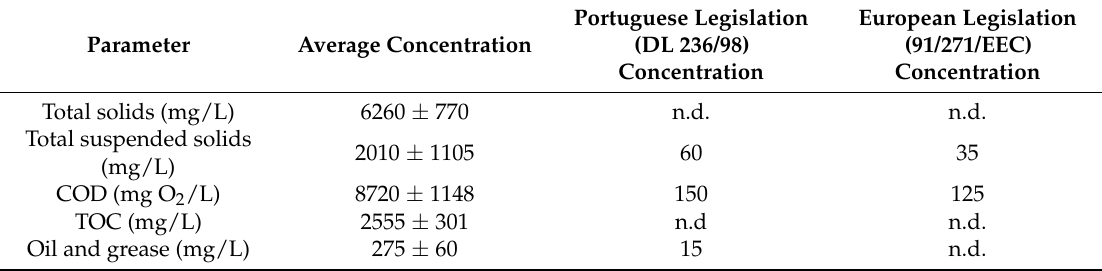
Table 2. Characterization of the real olive mill wastewater samples collected and limits imposed by legislation.